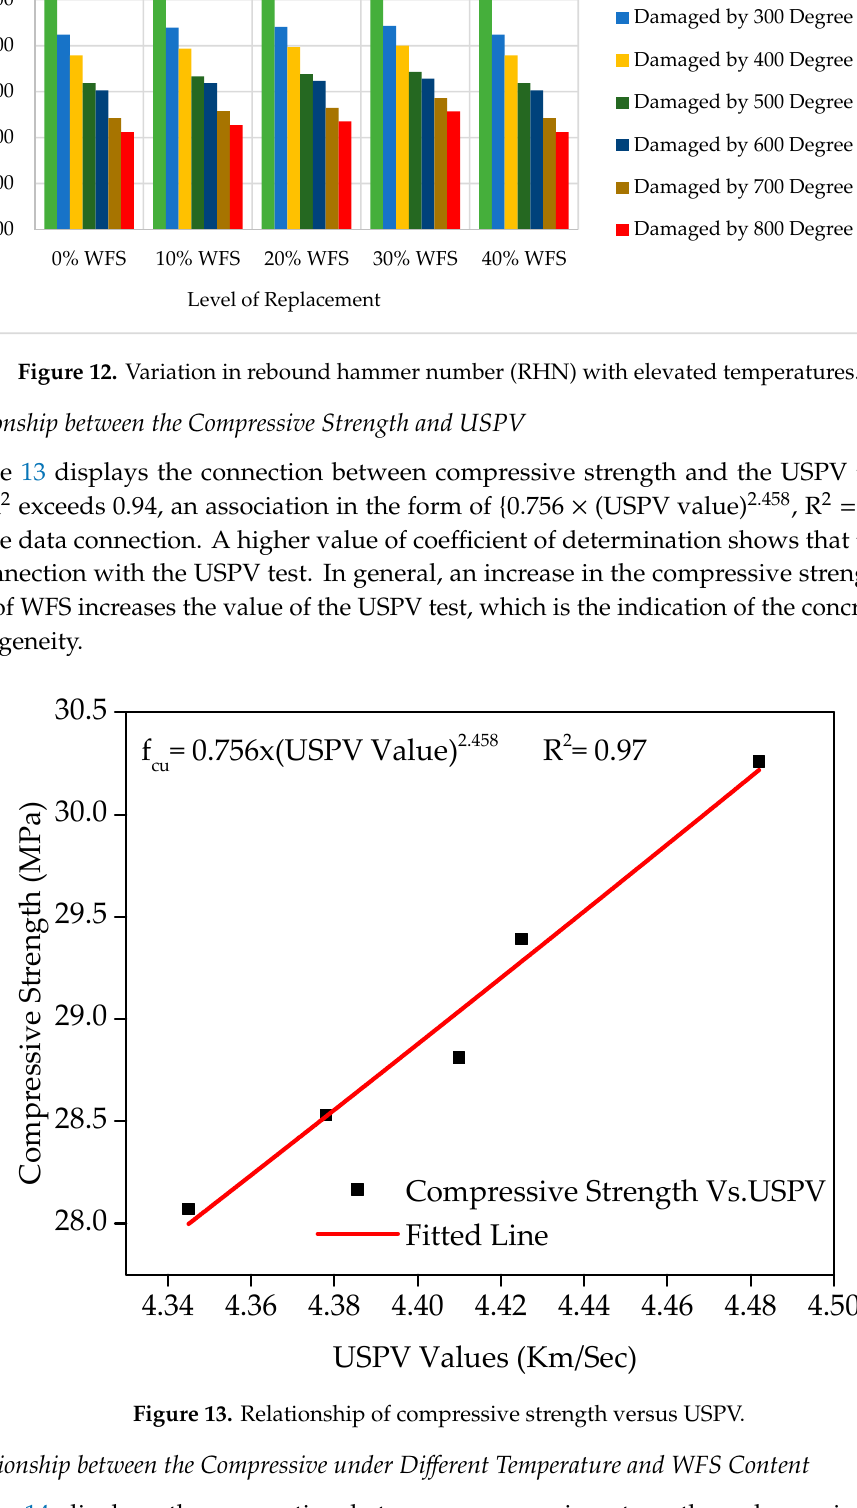
Figure 11. RHN values of WFS concrete at different temperature levels.